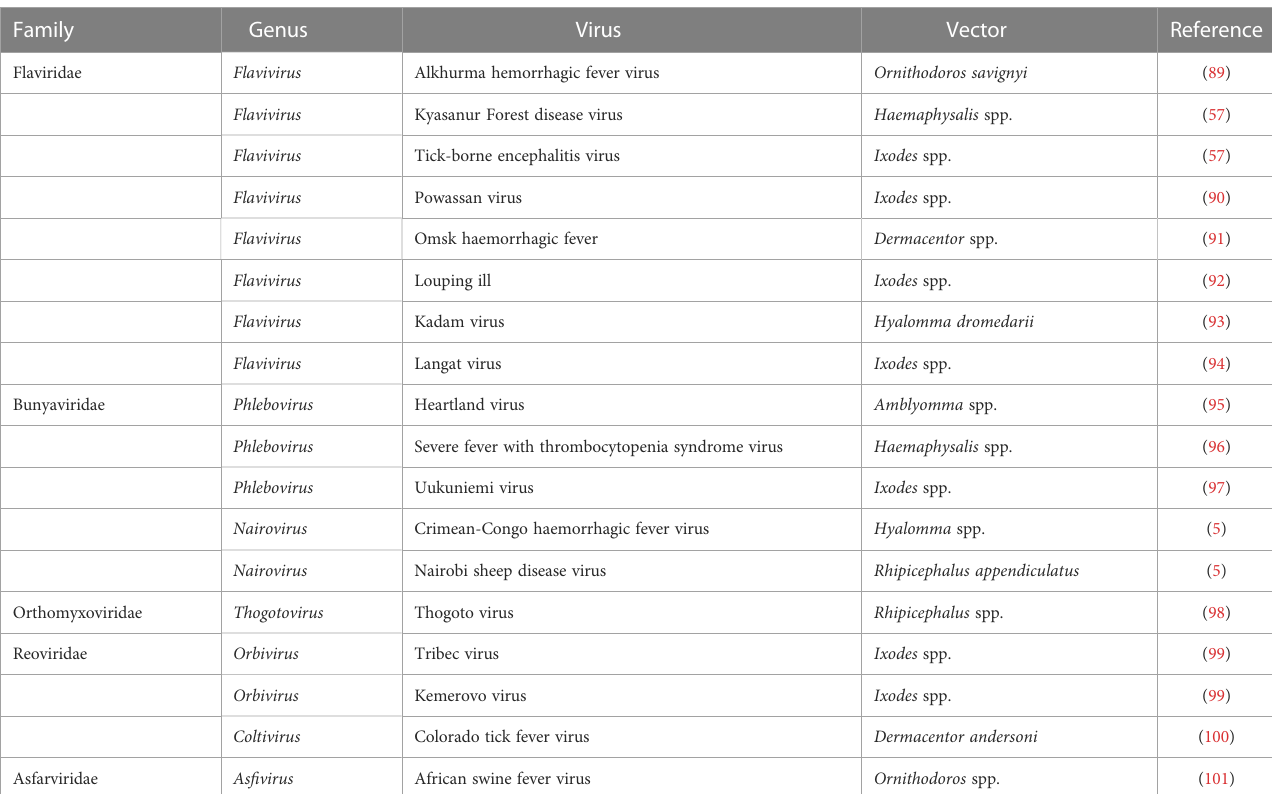
TABLE 2 Tick-borne